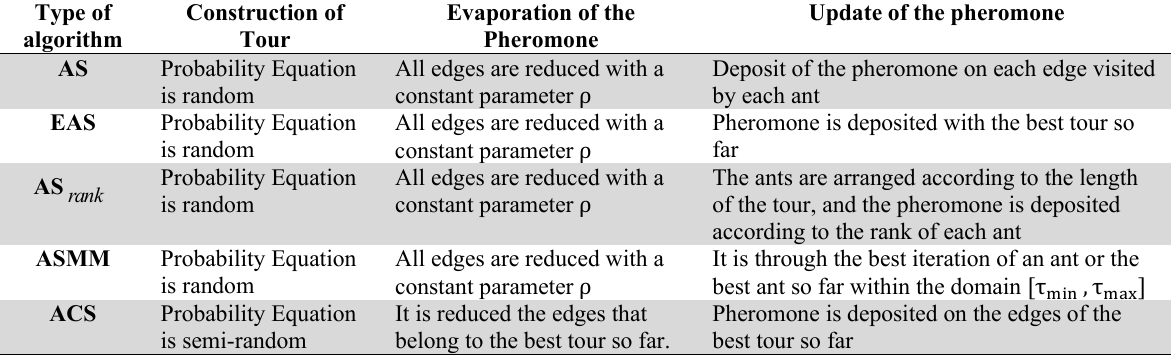
Shows the differences between the algorithms of ACO family Type